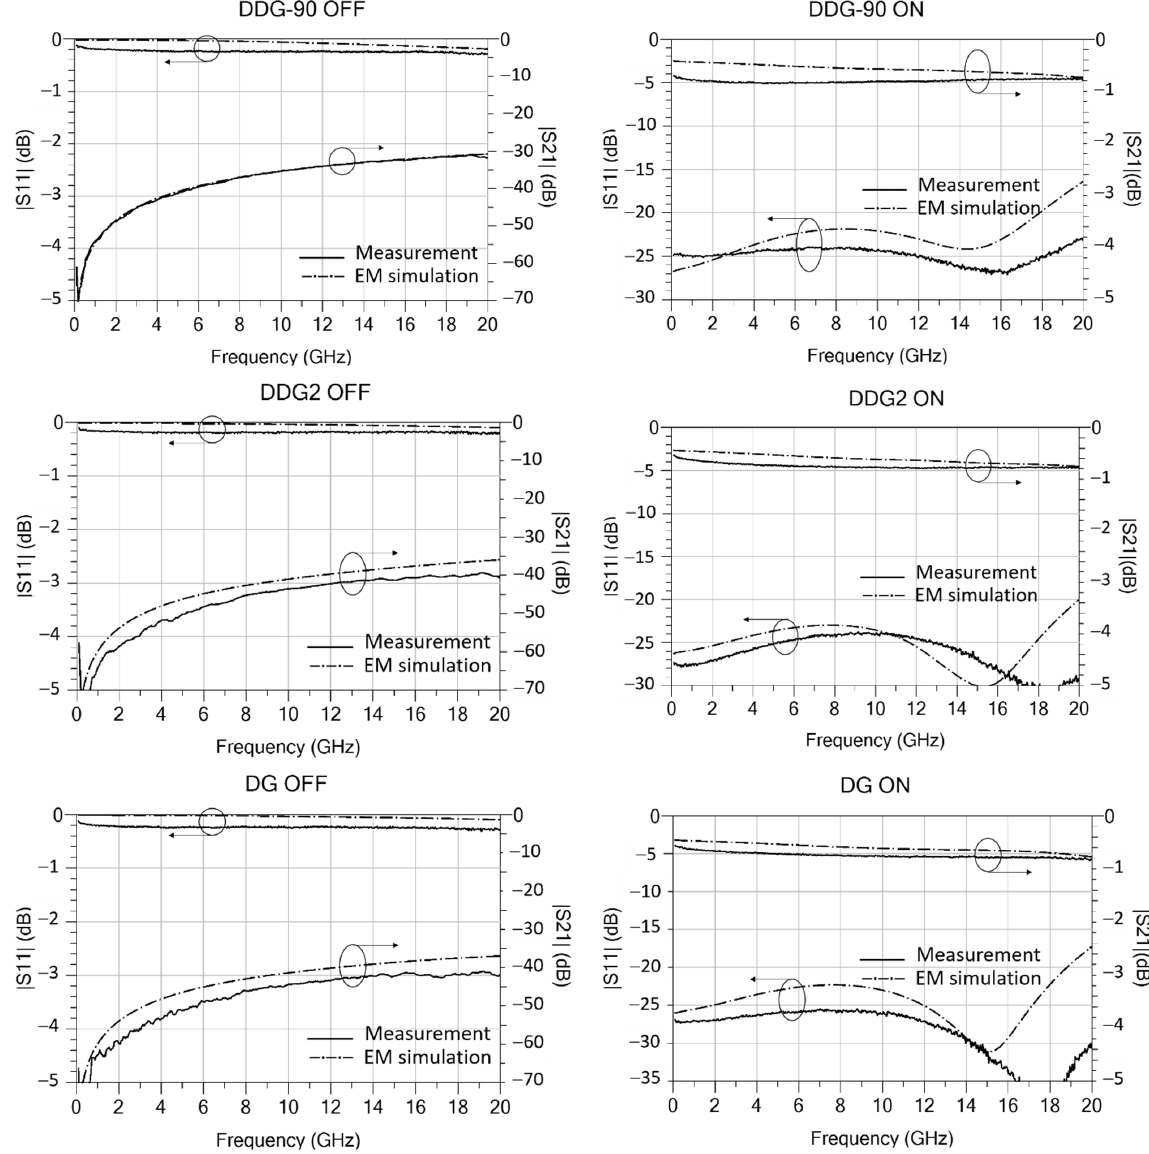
Figure 12. S-parameters of the fabricated RF-MEMS switches (Figure 1) measured using the set-up of Figure 12. S ‐ parameters of the fabricated RF ‐ MEMS switches (Figure 1) measured using the set ‐ up Figure 9, compared to EM simulation. In-line configurations: DDG, DDG2, and DG. The 90 ◦ -rotated of Figure 9, compared to EM simulation. In ‐ line configurations: DDG, DDG2, and DG. The 90° ‐ configuration: rotated configuration: DDG ‐ 90.